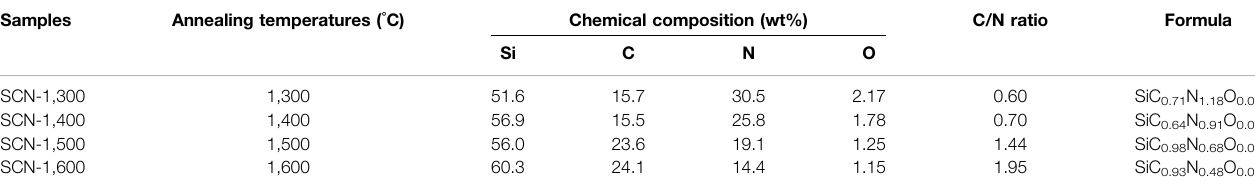
TABLE 1 | Chemical composition of SiCN fi bers with different annealing temperatures. Samples Annealing temperatures ( ° C)